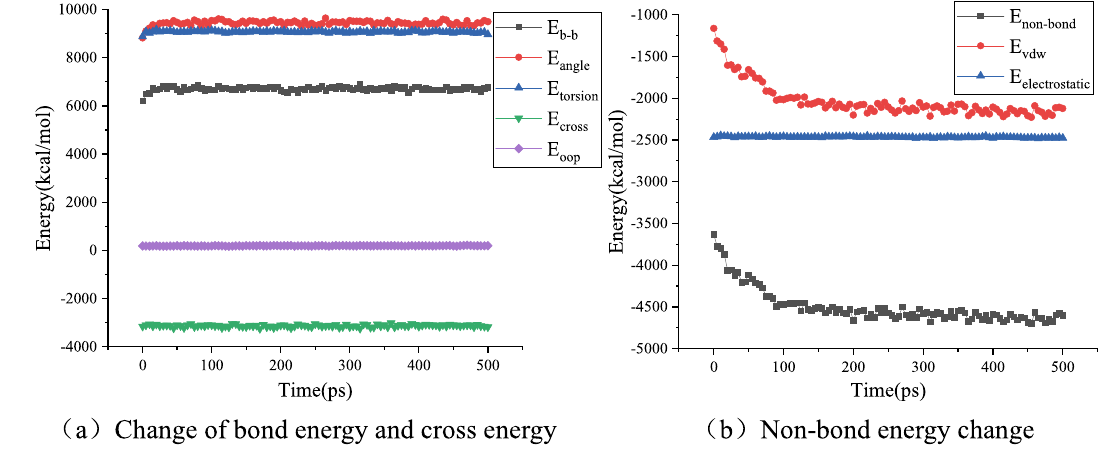
Figure 14. Energy change during virgin asphalt self-healing process.